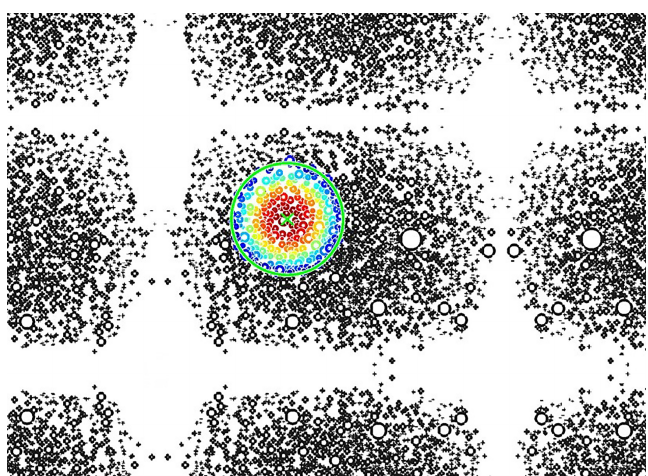
Figure 5. Mirrored image preventing image biasing near the boundaries. A single grid point is highlighted, showing the region of consideration used for local density